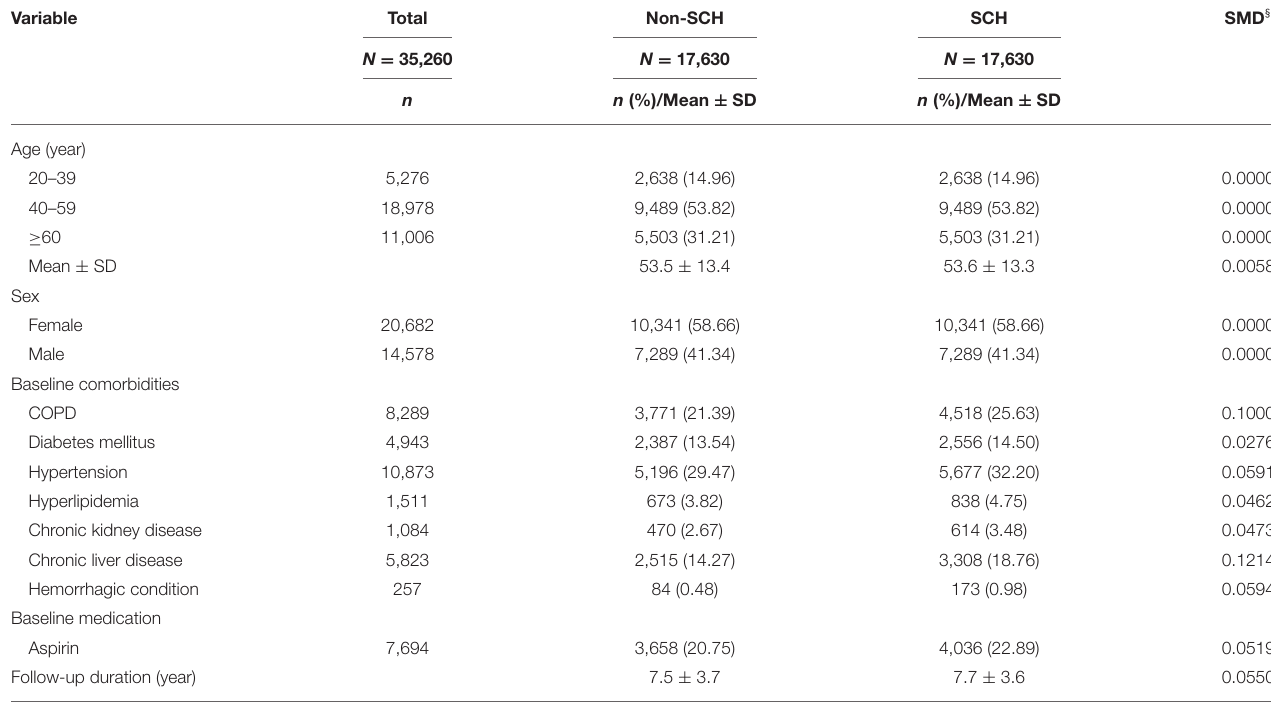
TABLE 1 | Characteristics of patients with and without SCH.